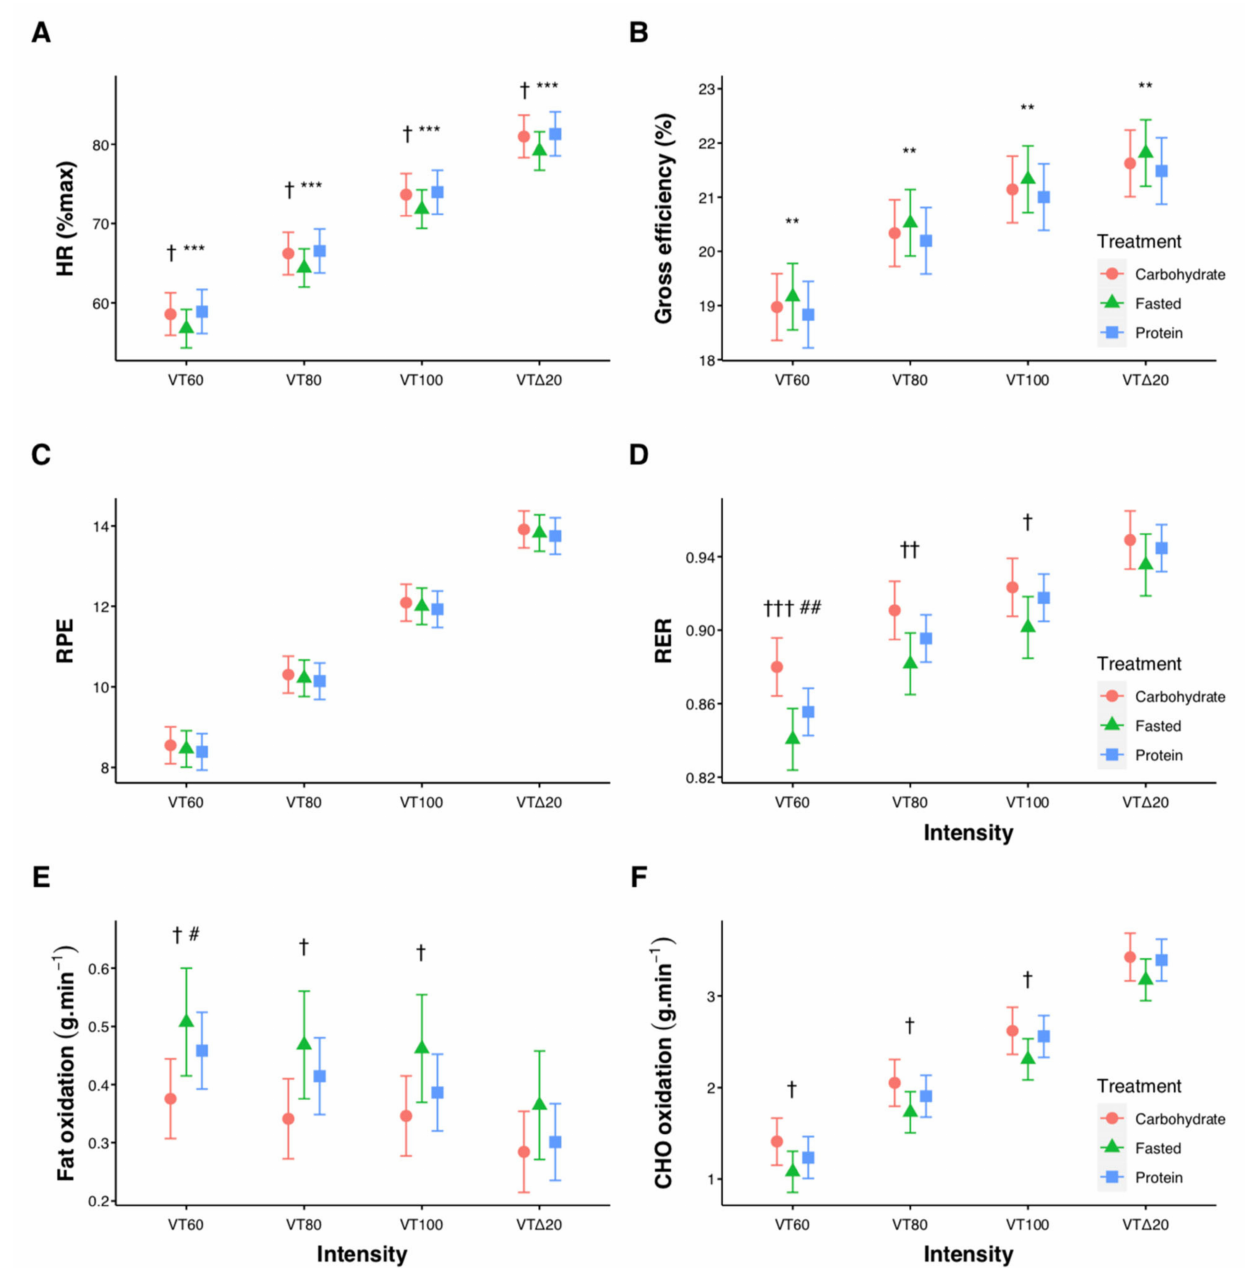
Figure 2. Influence of pre-exercise nutrition interventions on heart rate (HR, ( A )), cycling gross efficiency ( B ), rating of perceived exertion (RPE, ( C )), respiratory exchange ratio (RER, ( D )), fat oxidation ( E ), and carbohydrate (CHO) oxidation ( F ) during submaximal cycling. Significant differences CARB vs. FASTED († p < 0.05, †† p < 0.01, ††† p < 0.001), significant differences CARB vs. PROTEIN (# p < 0.05, ## p < 0.01), significant differences FASTED vs. PROTEIN (** p < 0.01, *** p < 0.001). Error bars represent 95% confidence intervals of the model-estimated